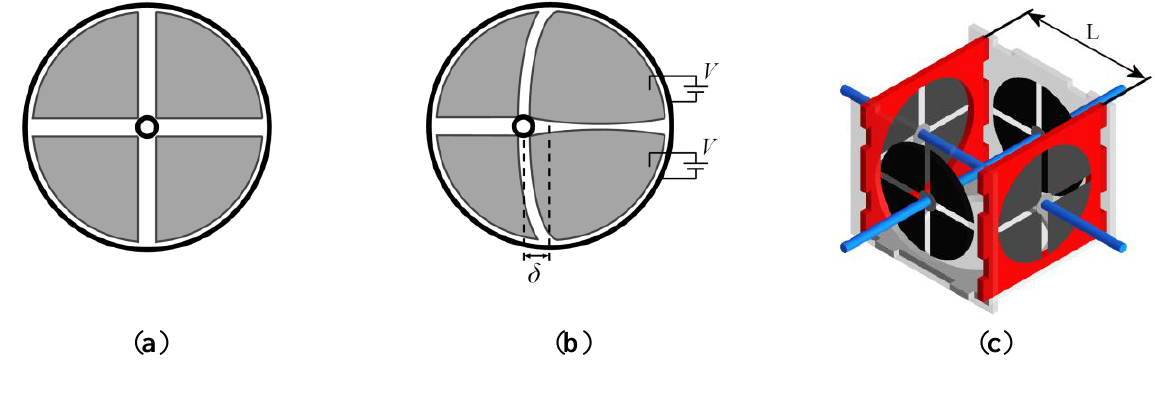
Figure 2. Schematic of a single DEA membrane with four electrodes ( shaded ) in: ( a ) passive state; and ( b ) active state with two electrodes actuated producing output displacement, δ . ( c ) Cube DEA design with the output of four membranes coupled using a cross rod. The characteristic dimension, L , of the cube DEA is the distance between each pair of parallel